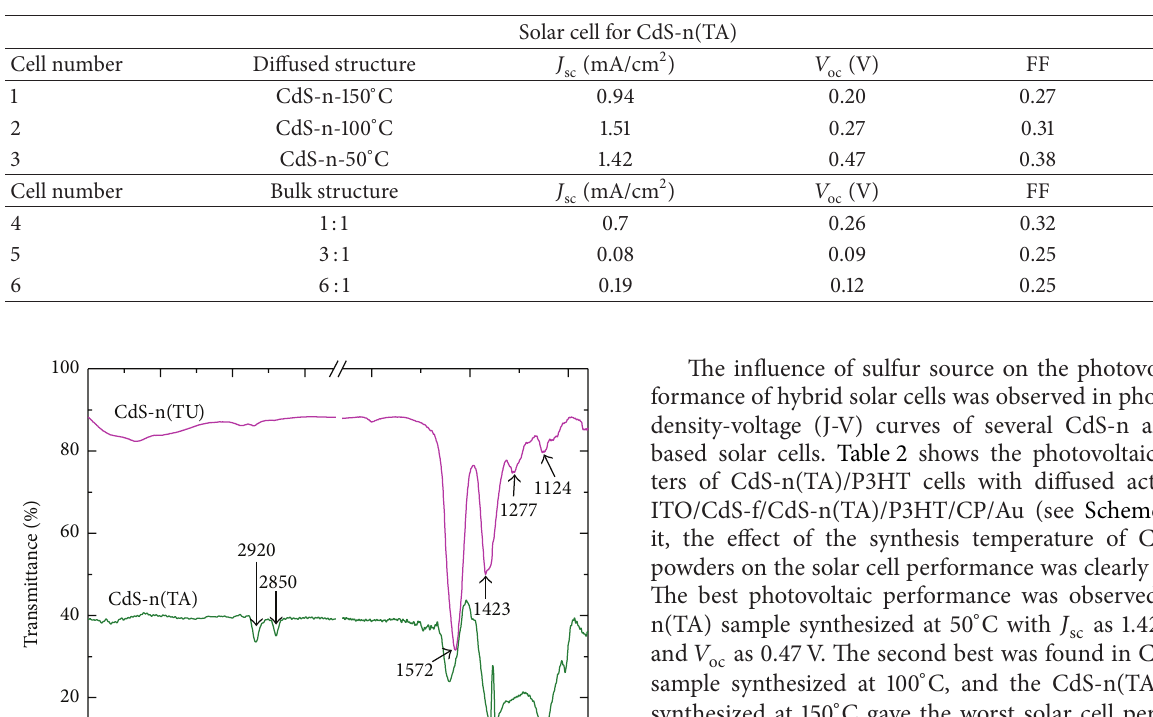
), photovoltage at open circuit ( 𝑉 ), fill factor (FF), and conversion efficiency ( 𝜂 ) sc oc